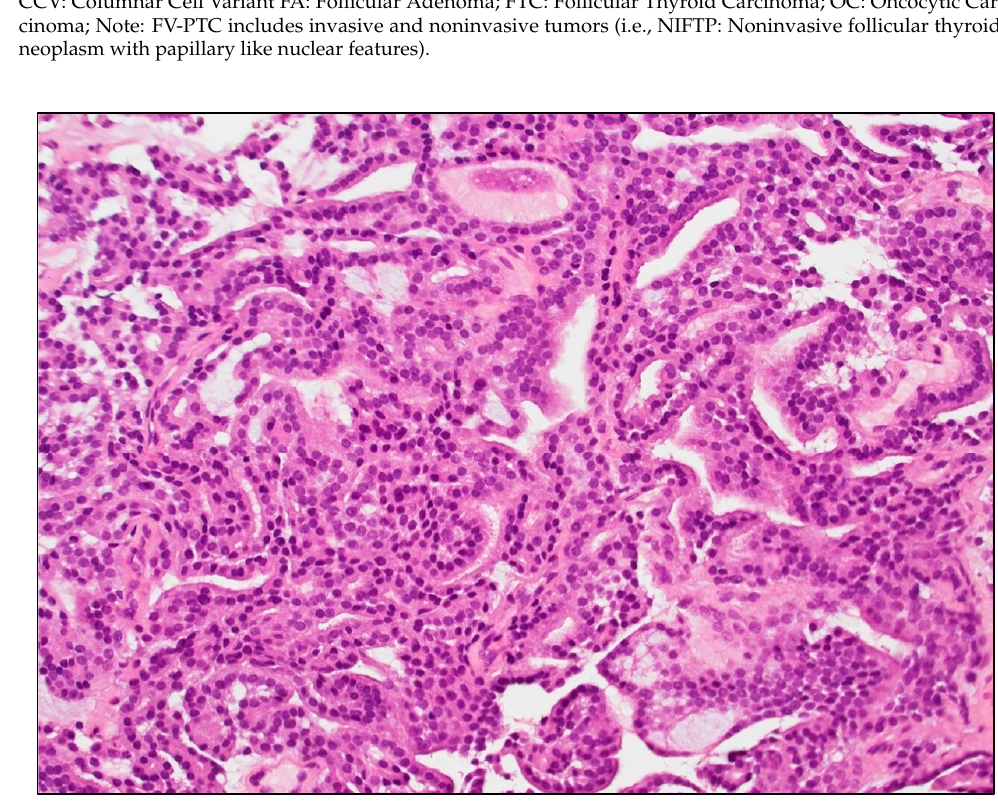
Figure 1. Follicular thyroid carcinoma metastatic to bone (sacrum), case 3 Table 1, harboring BRAF p.K601N. The tumor is follicular patterned, well-differentiated, and lacks the nuclear atypia of papillary carcinoma, mitotic activity, and tumor necrosis. Magnification: 100 ×